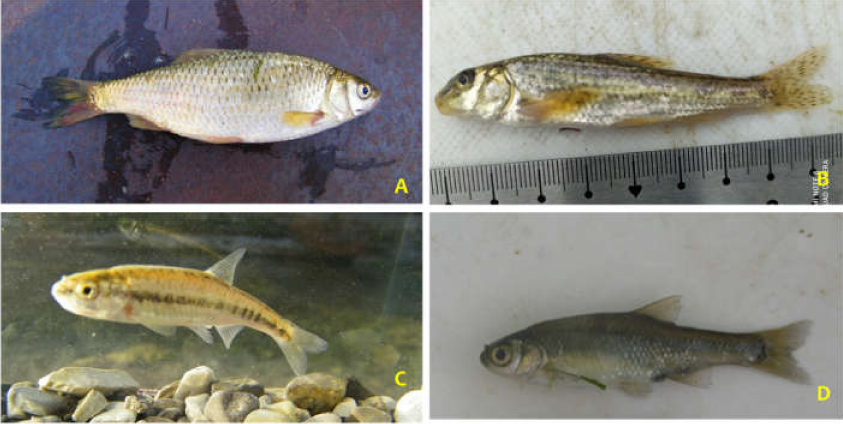
Figure 4. ( A ) Rutilus ohridanus ; ( B ) Gobio scadarensis ; ( C ) Phoxinus sp. ohridanus ; ( D ) Pelasgus minutes